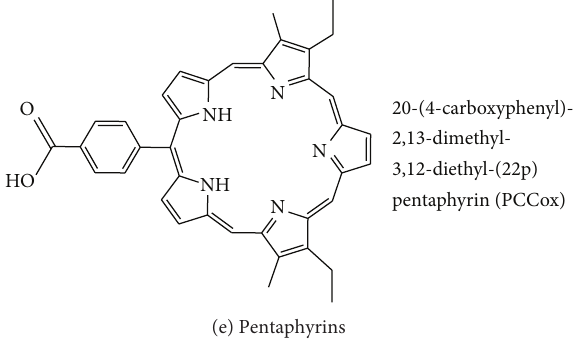
Figure 2: (a–e) Molecular structures, full names, and abbreviations of